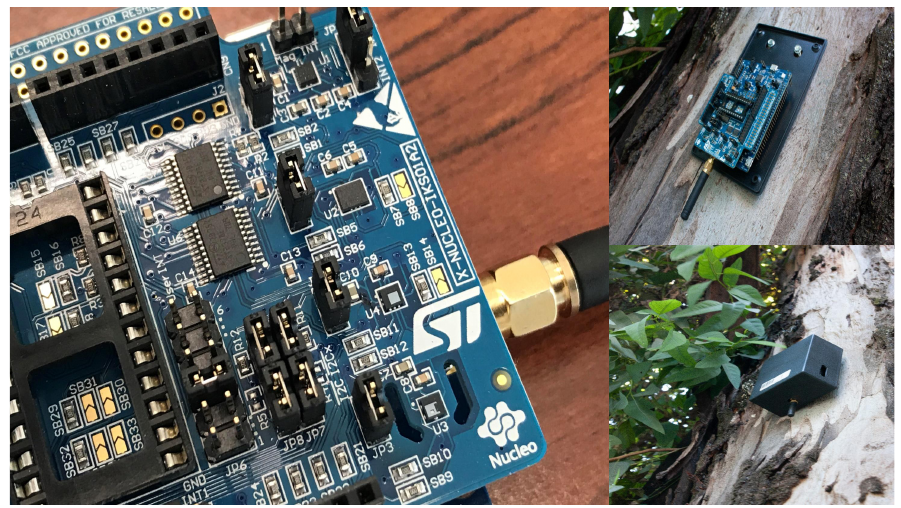
Figure 5. Sensor in a tree in the center of a building near to the entrance of the university